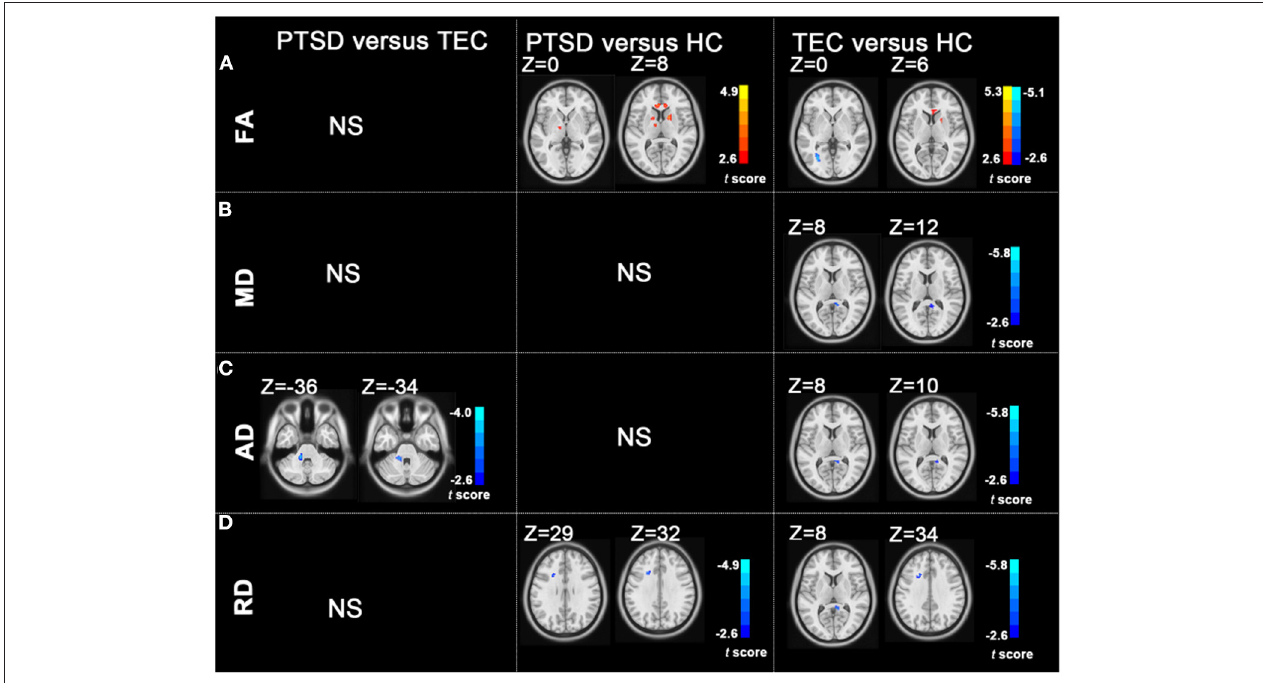
FIGURE 1 | Group differences in FA, MD, AD, and RD revealed by using post-hoc tests (A–D) . (A) The PTSD group showed increased FA values in the left posterior limb of the internal capsule, bilateral anterior limb of the internal capsule, right superior longitudinal fasciculus, bilateral anterior corona radiata, and right posterior corona radiata relative to the HC group; the TEC group showed decreased FA values in the left posterior corona radiata and increased FA values in the right anterior limb of the internal capsule, right posterior corona radiata, and bilateral anterior corona radiata relative to the HC group. (B) The TEC group had decreased MD values in the right cingulum relative to the HC group. (C) The PTSD group had decreased AD in the left middle cerebellar peduncle compared with the TEC group. The TEC group had decreased AD in the right cingulum relative to the HC group. (D) Patients with PTSD had decreased RD in the left anterior corona radiata compared with the HC group. The TEC group had decreased RD in the right cingulum, right inferior fronto-occipital fasciculus, right inferior longitudinal fasciculus, and left anterior corona radiata relative to the HC group ( P < 0.05, GRF corrected). PTSD, posttraumatic stress disorder; TEC, trauma-exposed controls; HC, healthy controls; FA, fractional anisotropy; MD, mean diffusivity; AD, axial diffusivity; RD, radial diffusivity; GRF, Gaussian